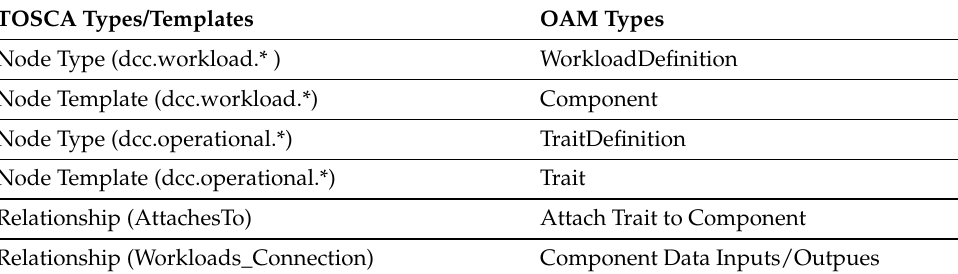
Table 1. TOSCA-to-OAM entity